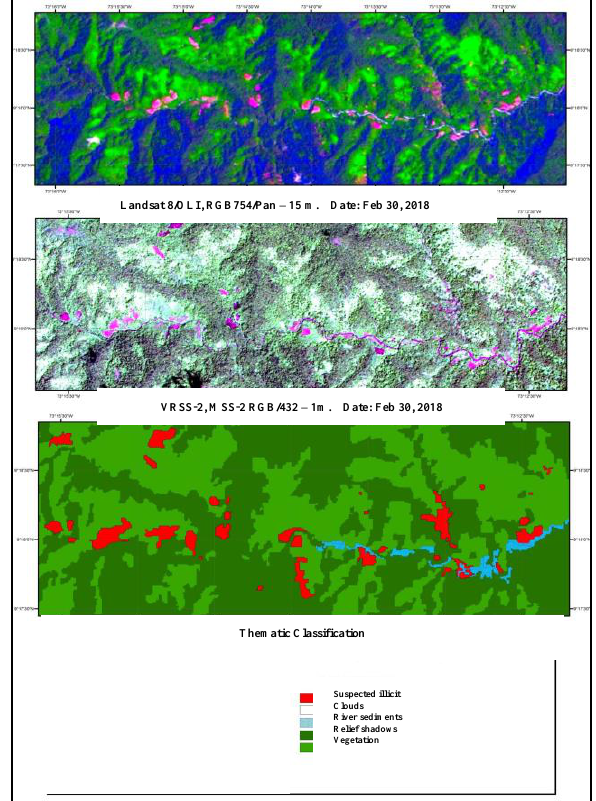
Figure 8. Potential areas for planting illicit crops